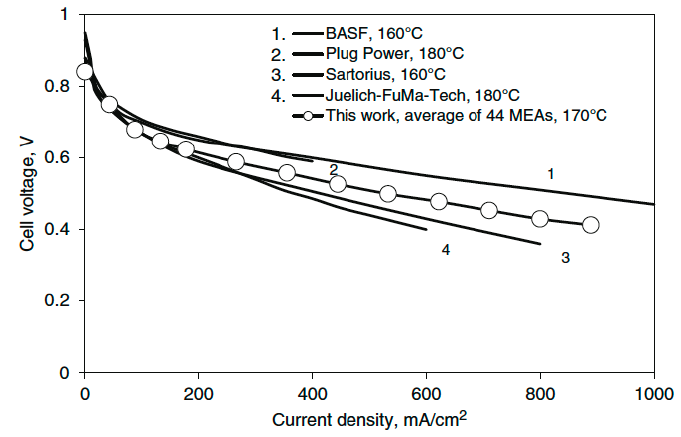
Figure 3. Fuel cell performances of commercial membranes compared with a blend one (taken from Ref. [34]).